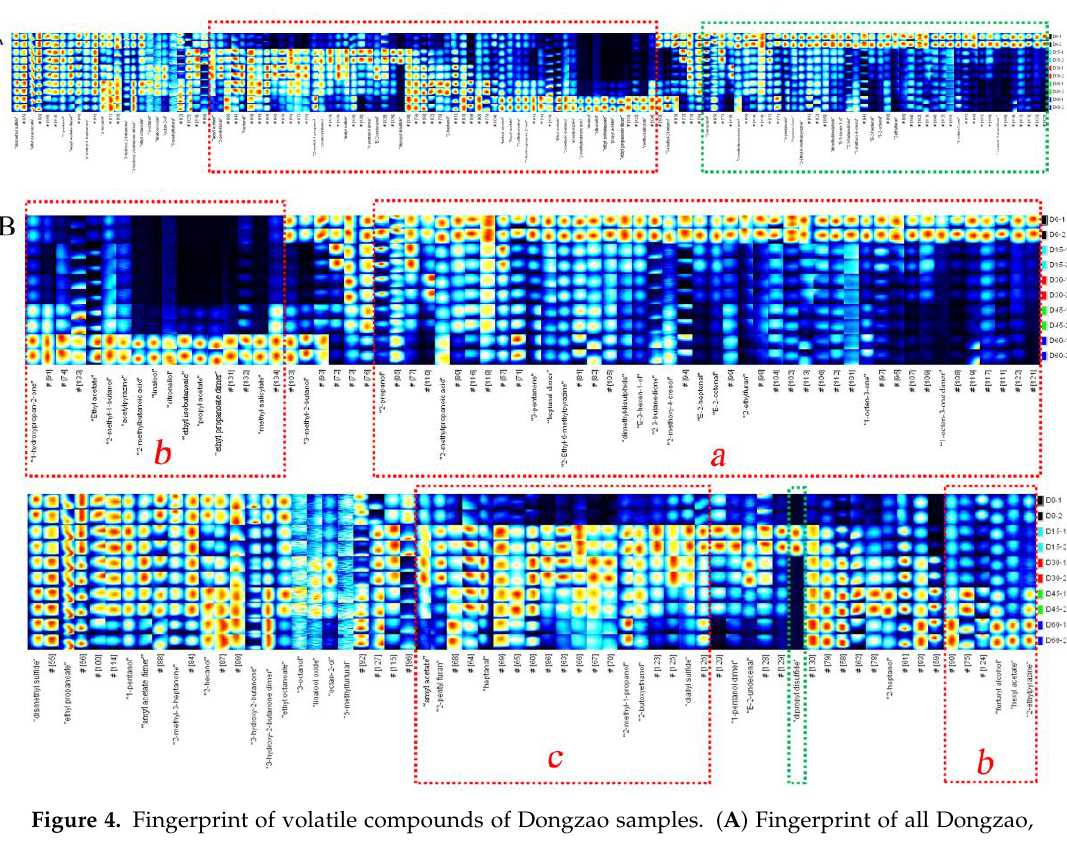
Figure 4. Fingerprint of volatile compounds of Dongzao samples. ( A ) Fingerprint of all Dongzao, ( B ) two parts of the fingerprint.